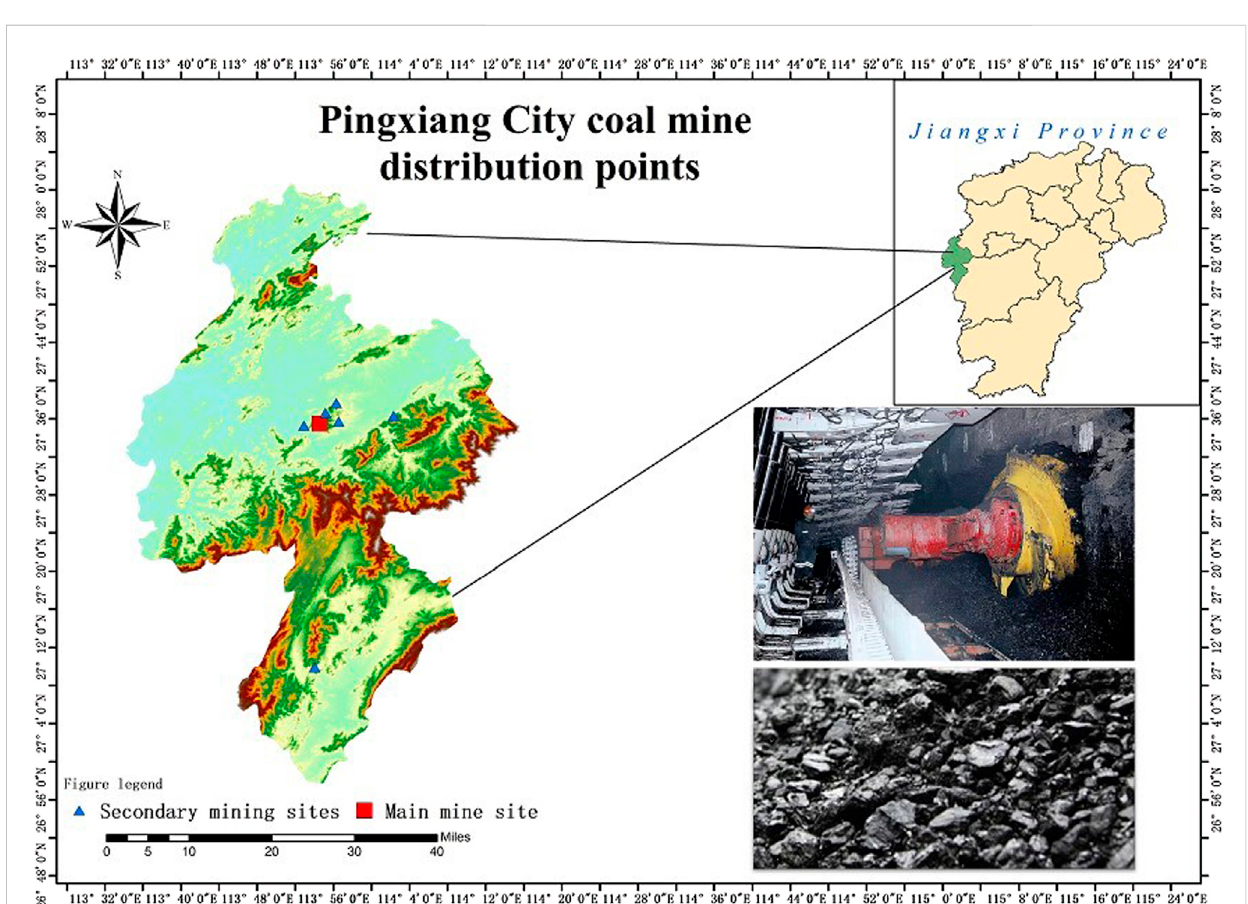
FIGURE 2 The geographic location map of the study